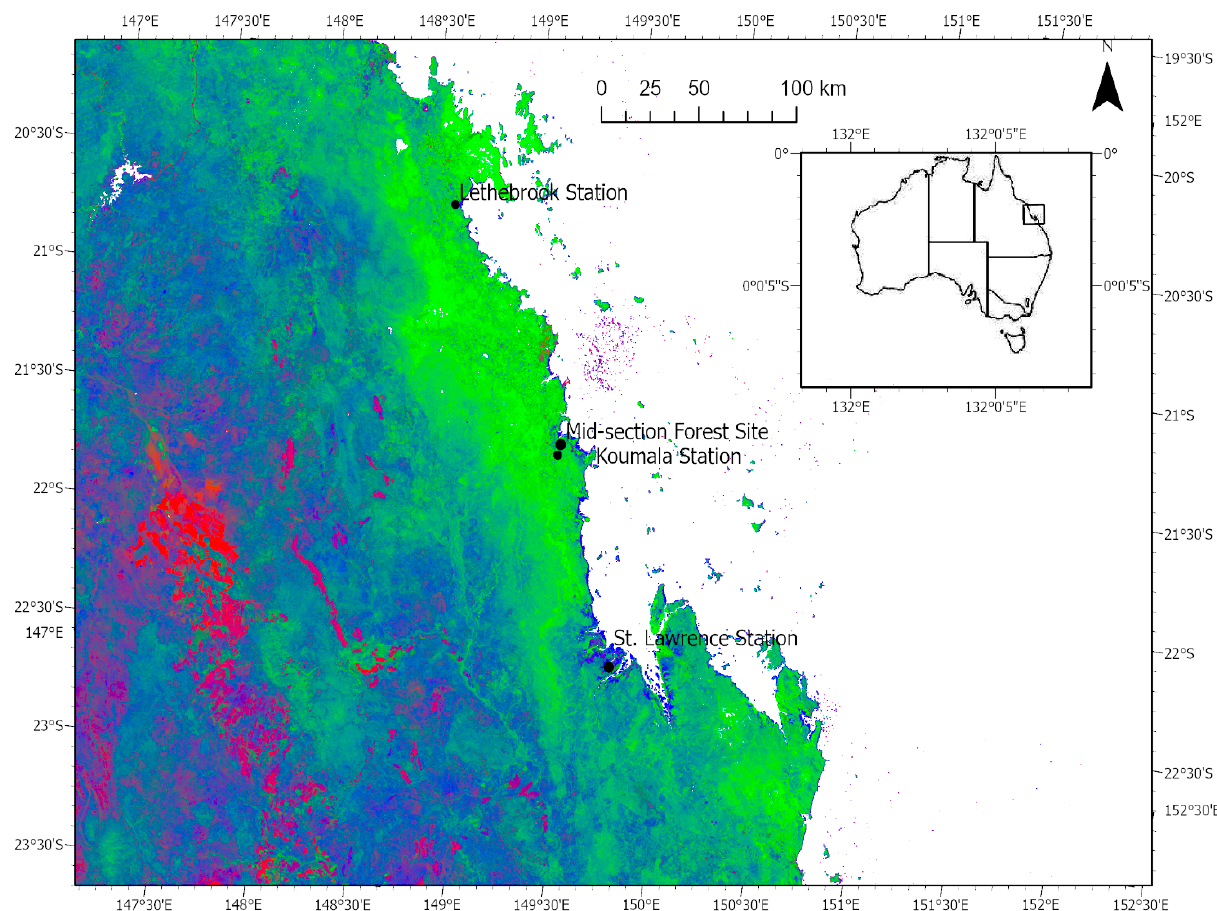
Figure 1. Study site with weather stations at Lethebrook, Koumala, and St. Lawrence-Bowen to Shoalwater and Corio Bays Area Ramsar Wetland, Central Queensland-Landsat fractional cover image visualised by using the Band 1-red (bare ground and rock), Band 2-green (vegetation), Band 3-blue (non-green vegetation indicative of drier habitats with less vegetative cover), provided by